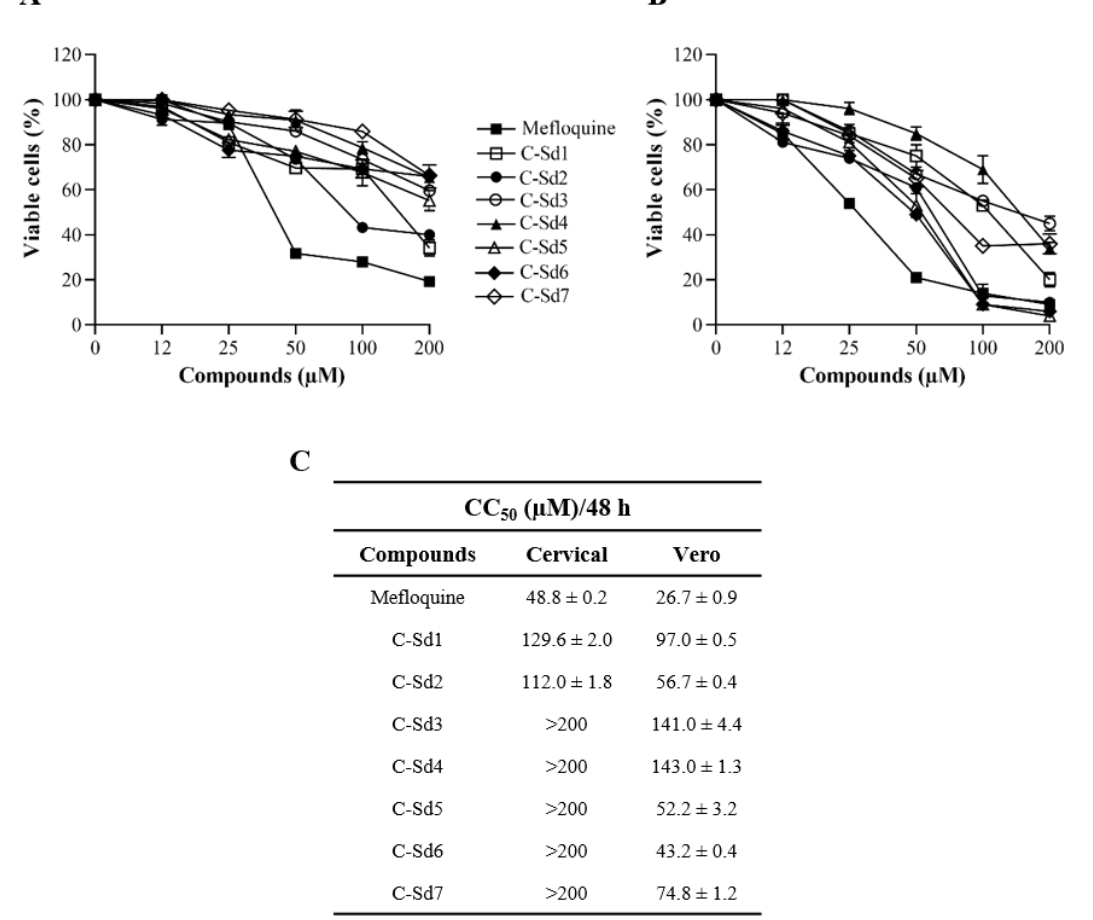
Figure 1. Kinetics of cellular viability of C-Sds hybrids and mefloquine were evaluated by PrestoBlue assay. The cervical and Vero cell lines were treated with C-Sds and mefloquine at different concentrations for 48 h. The graphs represent the mean ± standard deviation of the percentage of viable ( A ) cervical cells and ( B ) Vero cells. ( C ) The table shows the values of CC 50 /48 h of C-Sds and mefloquine. The data are representative of 3–5 experiments run in duplicate.